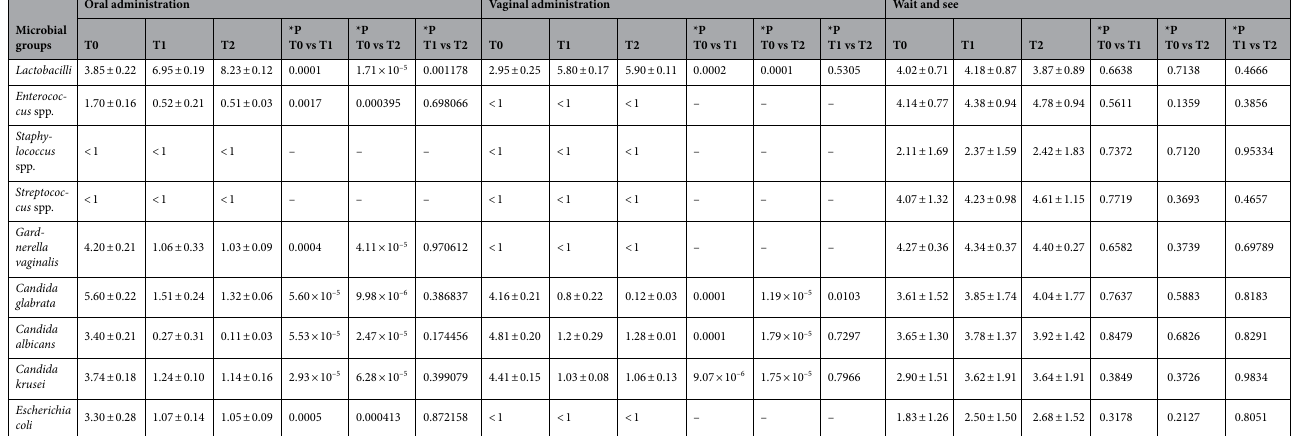
Table 6. Microbiological analysis and ANOVA significance of vaginal discharge collected at baseline (T0), after 10 days of the L. rhamnosus TOM 22.8 strain administration (T1) and 1 month after the L. rhamnosus TOM 22.8 strain administration (T2). Data are shown as mean and standard deviation. *Statistical significance P < 0.05.